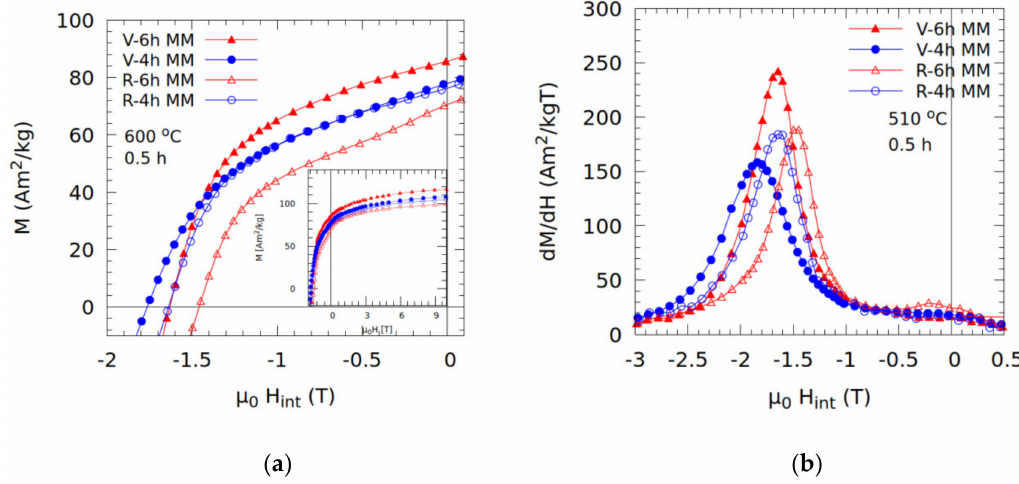
Figure 5. The demagnetization curves ( a ) as well as the dM / dH curves ( b ) for virgin (V) and recycled (R) samples milled for 4 and 6 h and annealed at 600 ◦ C for 0.5 h. Magnetization curves, up to 10 T, for the samples are given in the figure (a) inset.